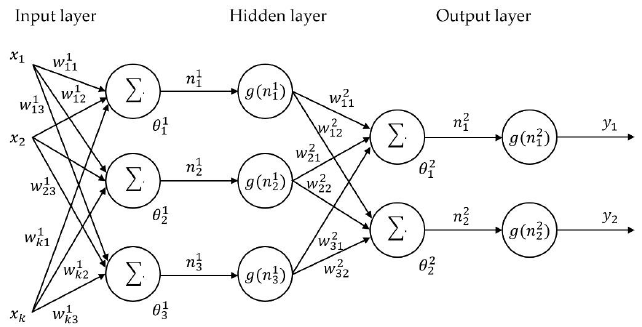
Figure 3. Diagram for artificial neural networks.